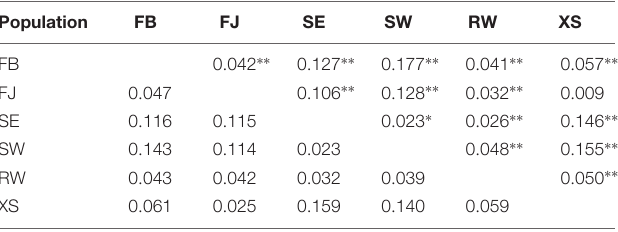
TABLE 1 | Genetic diversity and selfing rates of the populations of Saccharina japonica from a typical farm and the adjacent subtidal zones in Dalian, China. Population N a F is Selfing rate ( g 2 )